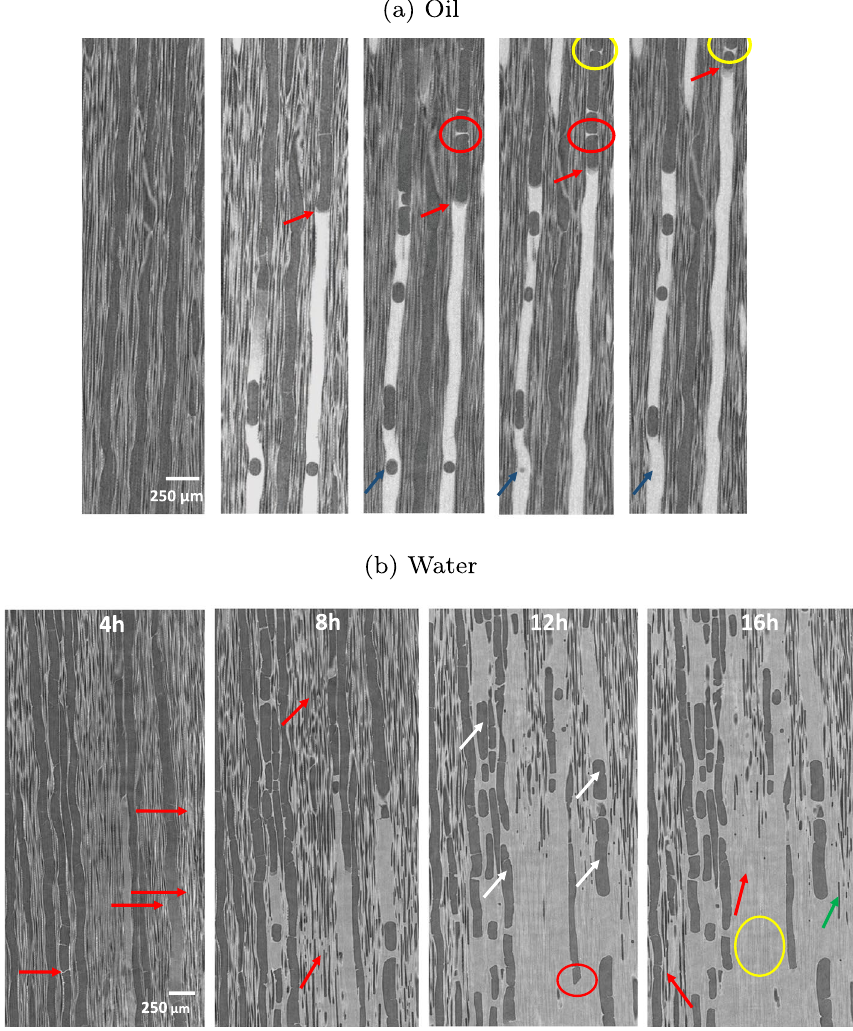
Figure 4. Imbibition in poplar: micro-tomography TL sections at different